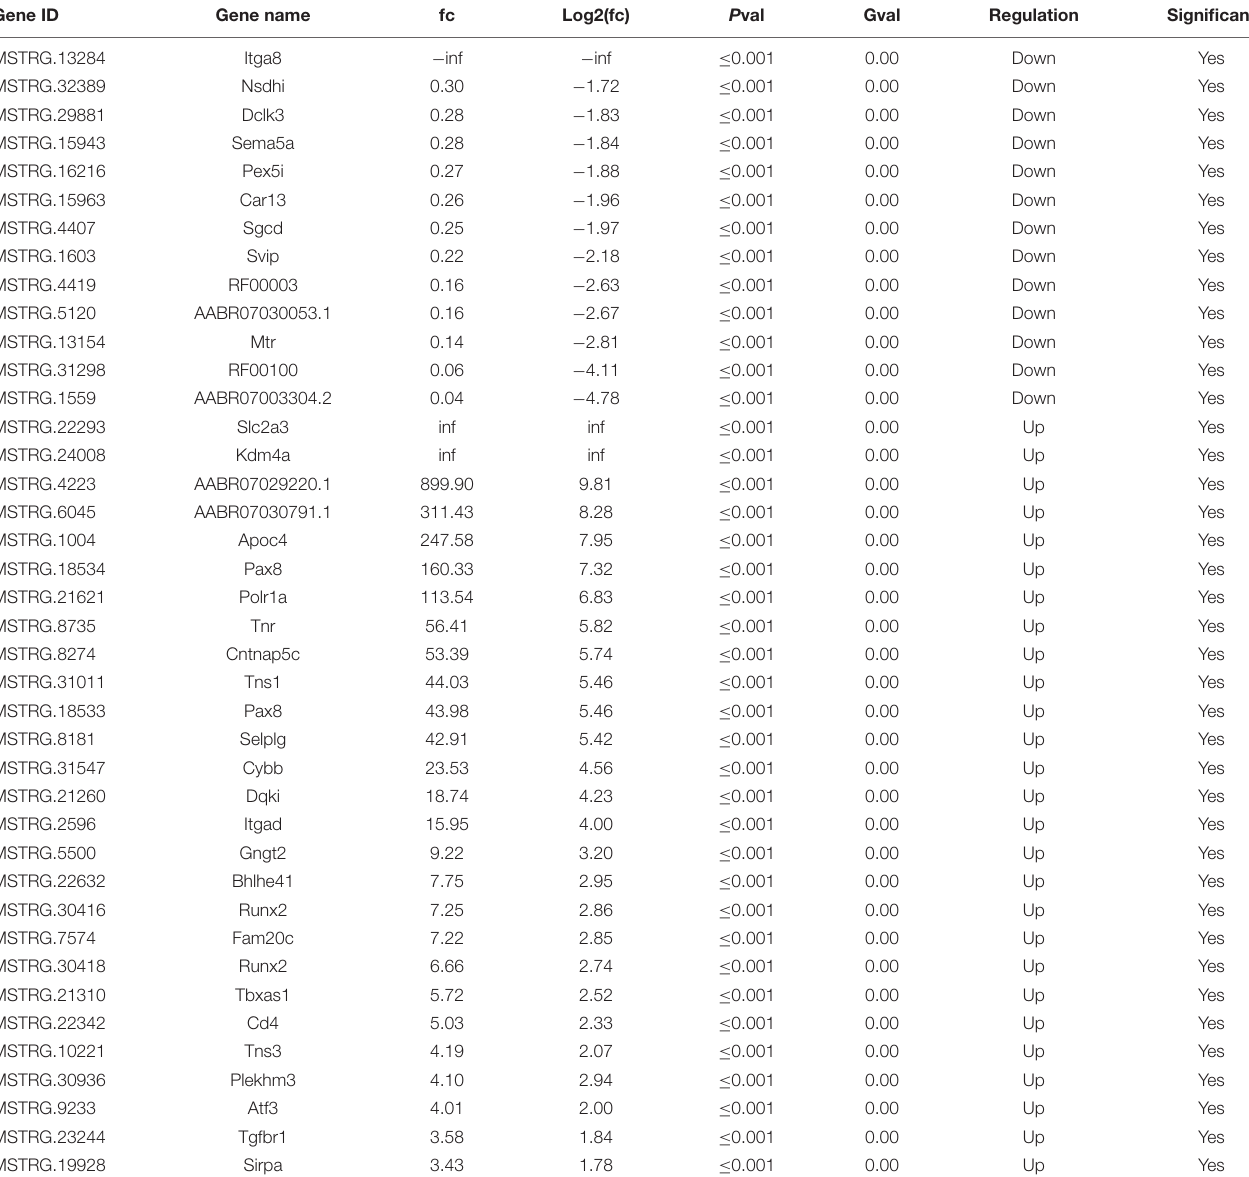
TABLE 1 | Injury-related lncRNAs were screened by high-throughput